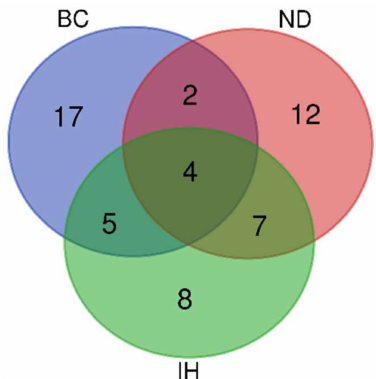
Figure 1. Gene Venn showing microRNA under investigation in selected pathologies of the brain (based on Table 2) (Brain Cancer (BC), Neurodegenerative Disorders (ND) Ischemia (IH)). MiR-21 , let-7 , miR-210 and miR-128 are common